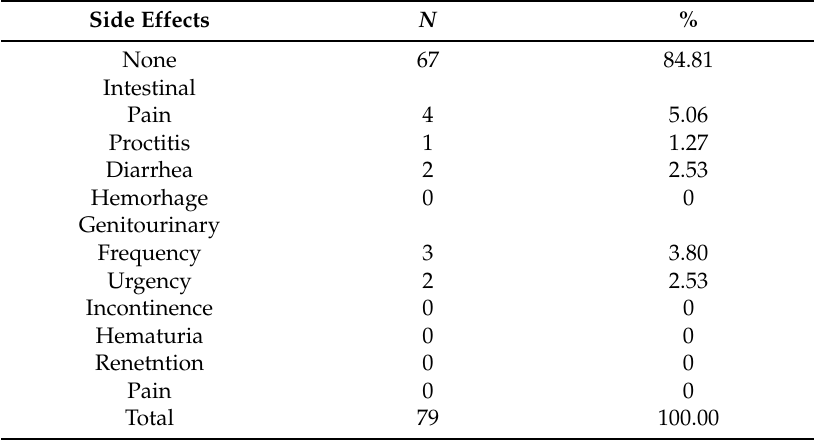
Table 6. Early toxicity rates after radiation therapy.